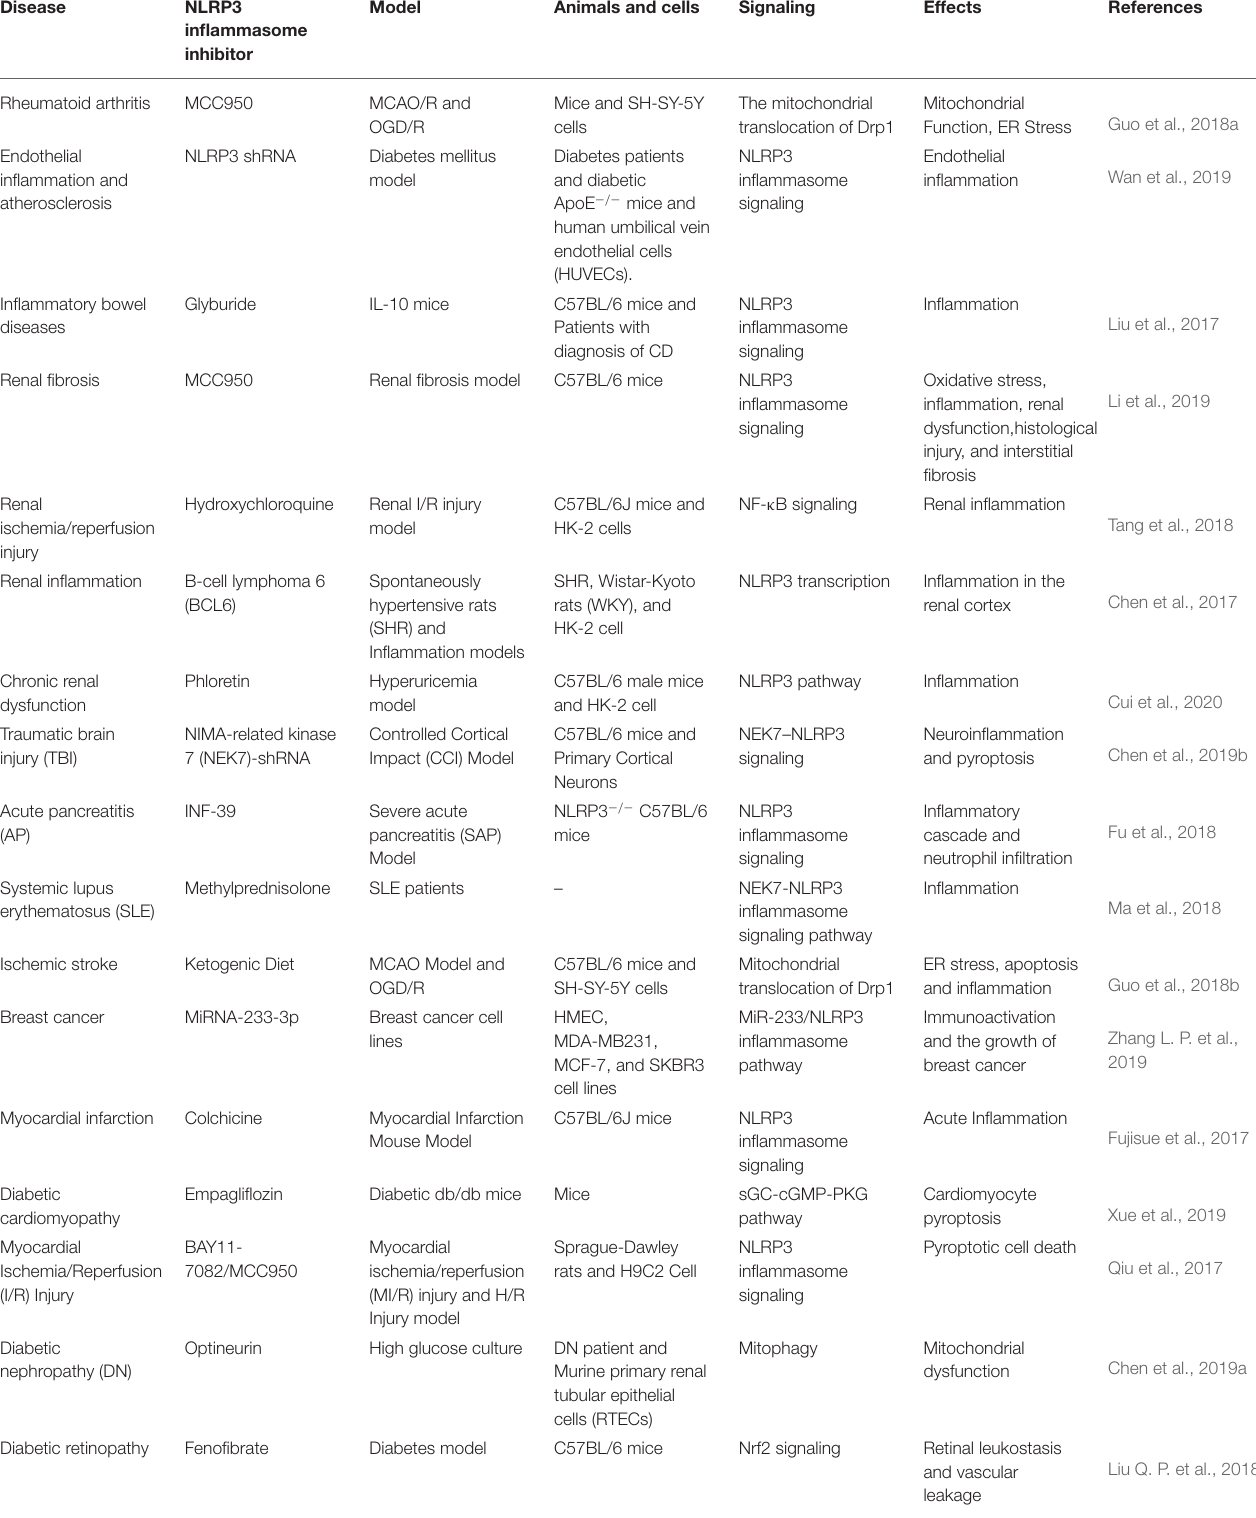
TABLE 1 | Diseases associated with pyrin domain-containing protein 3 (NLRP3) inflammasome.